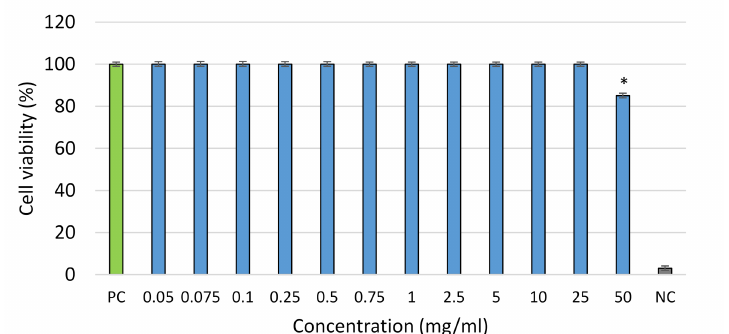
Figure 3. Cytotoxic e ff ect of hydromethanolic extract from transformed shoots of D. forrestii grown for 3 weeks in NBS in MS medium with BPA 0.5 mg / L and IAA 0.2 mg / L against L929 cells (blue column). The results are expressed as means of three replicates ± SE. The value followed marked by (*) was significantly di ff erent with comparison other according to the Mann–Whitney U test ( p < 0.05). PC: positive control (cells culture in the culture medium alone) (green column), NC: negative control (cells treated with 0.03% H 2 O 2